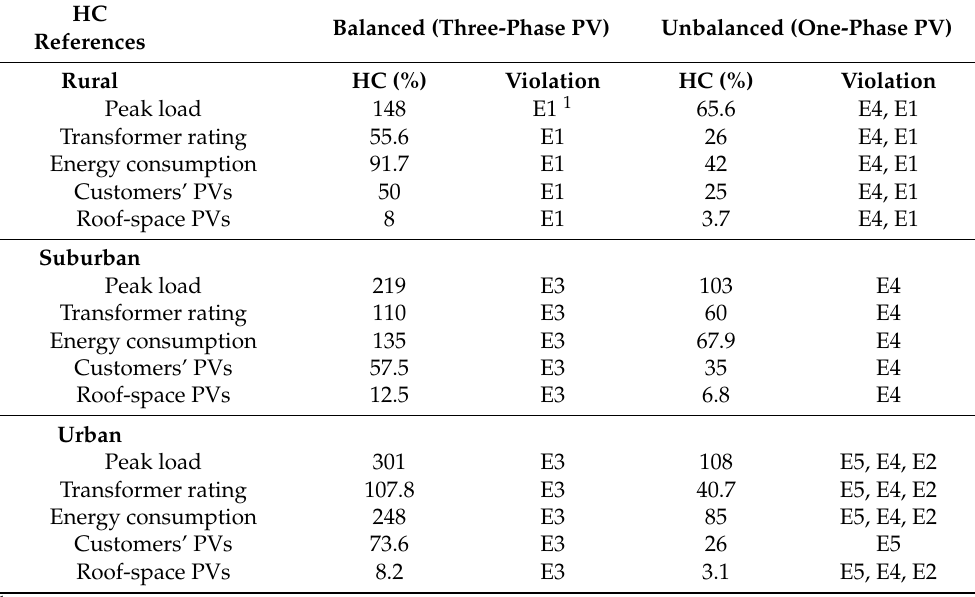
Table 5. HC values as compared to different references for balanced and unbalanced PV